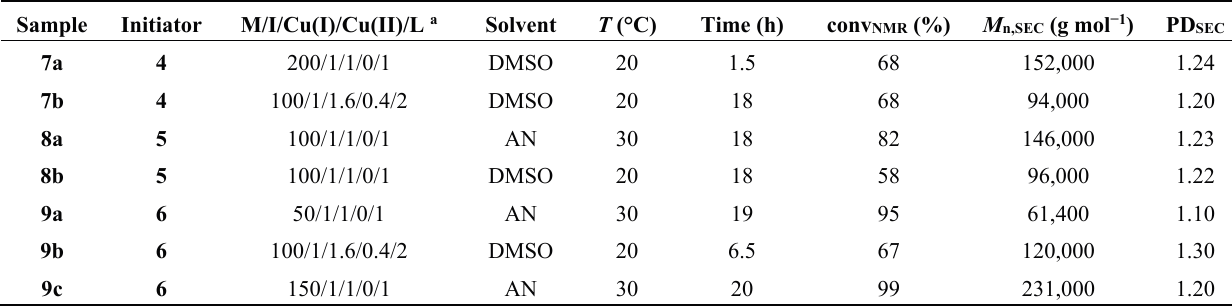
Table 1. Experimental results for the synthesis of star-like PNIPAAm homo